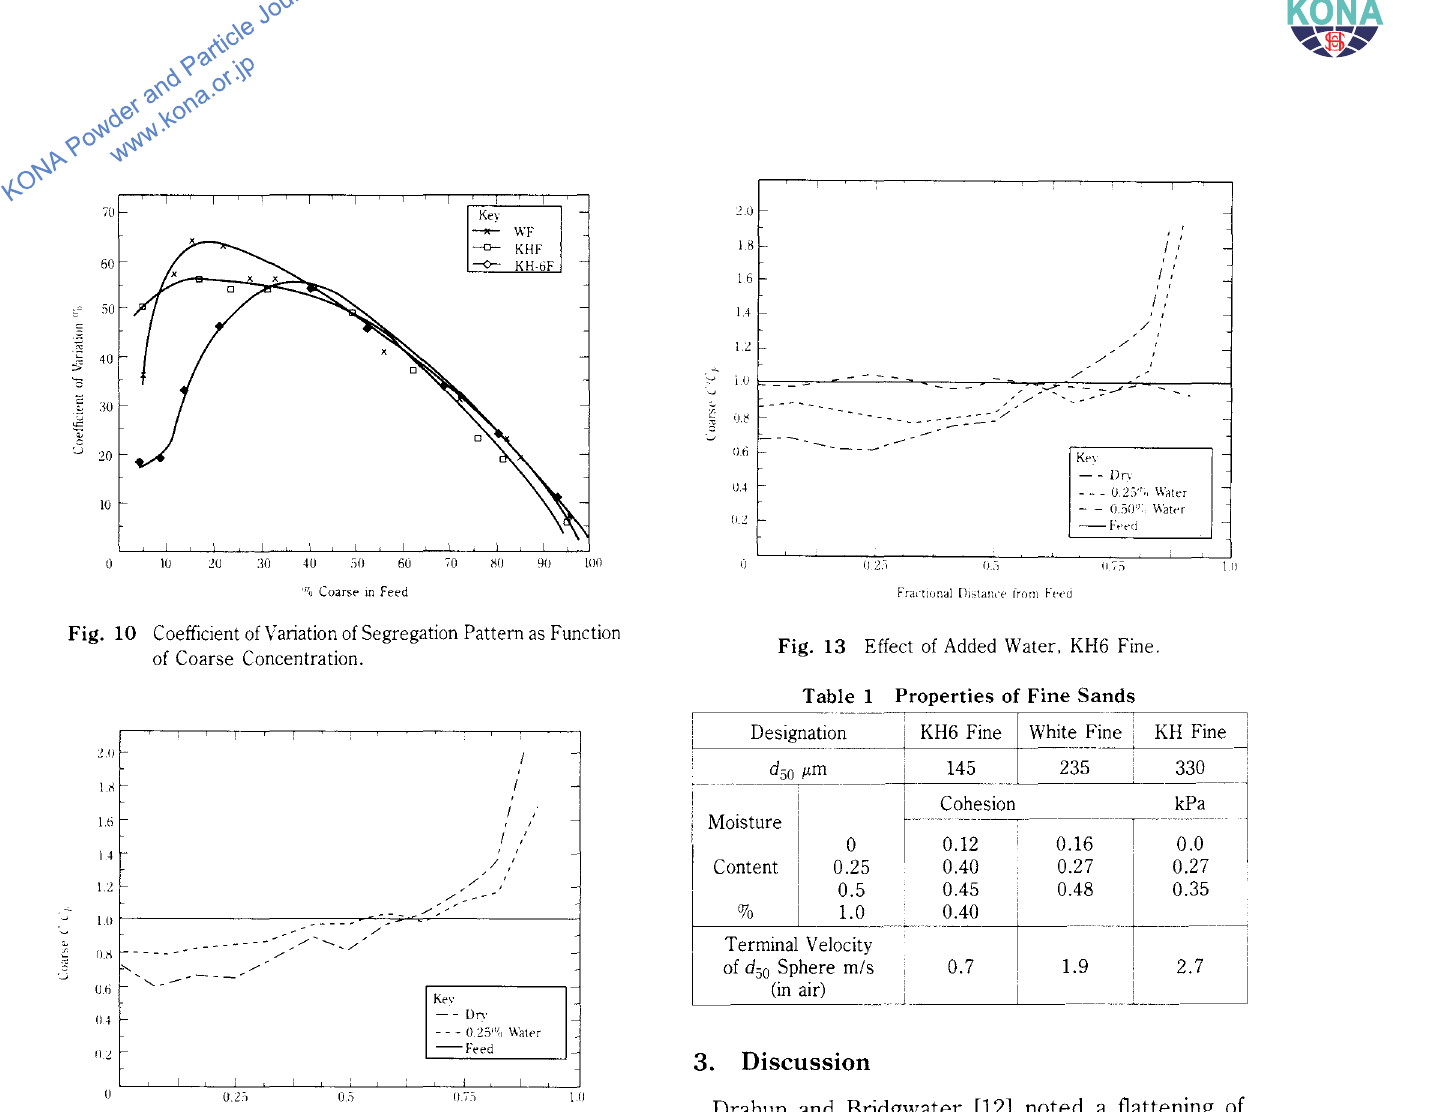
Fig. 13 Effect of Added Water, KH6 Fine. Table 1 Properties of Fine